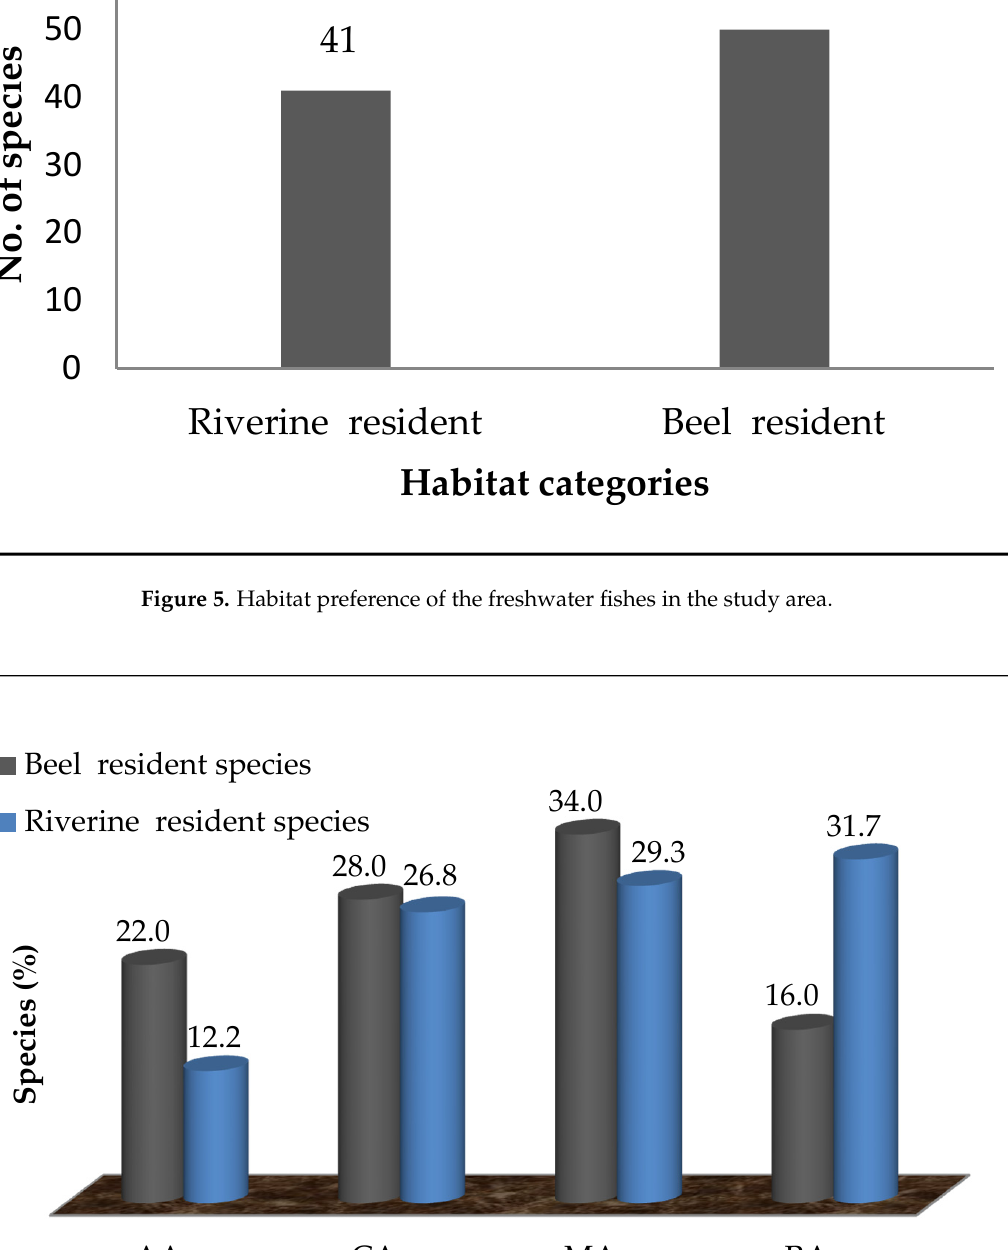
251 Figure 4. Present fish diversity status of the study area. 3.3. Habitat Based Status of Fish Fauna In Bangladesh there are three well known categories of freshwater fishes based on their residential status, such as riverine, migratory, and floodplain resident species. For instance, during the dry season when the water levels of the floodplains reach their nadir, several floodplain-dwelling species take shelter in nearby perennial water bodies such as rivers and deeper beels [6], which makes their categorization more complex. However, the maximum lifespan of freshwater fishes is spent in rivers and/or perennial beels . Hence, in